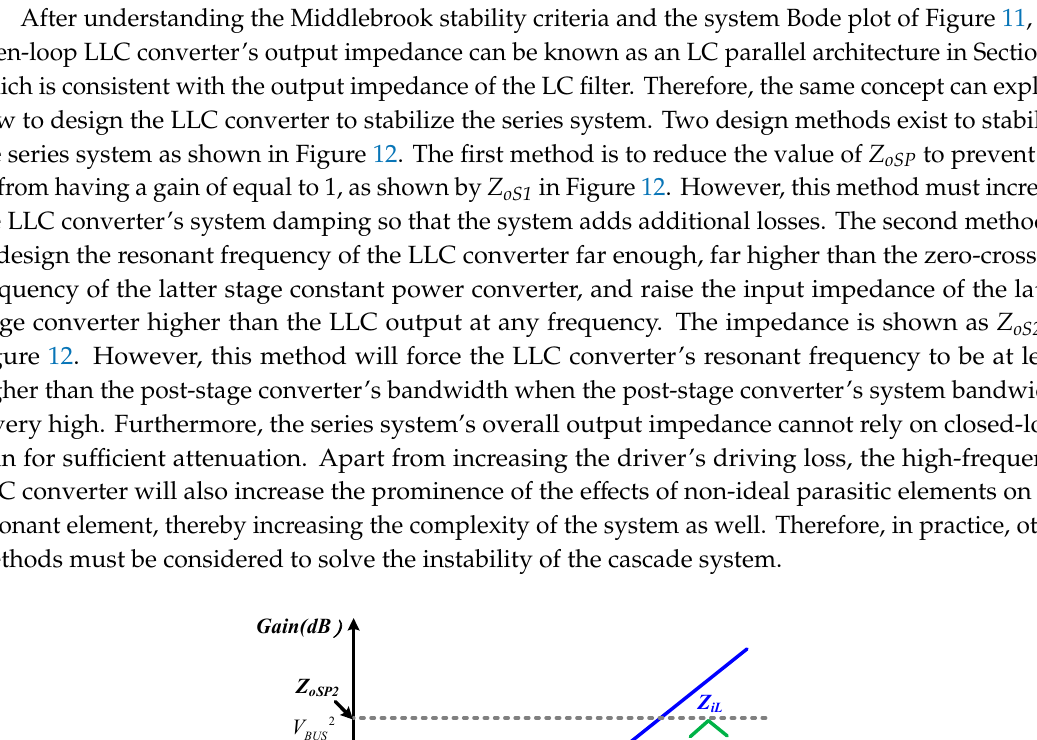
Figure 11. Bode plot of an unstable series system of LC filter in series with constant power load converter.